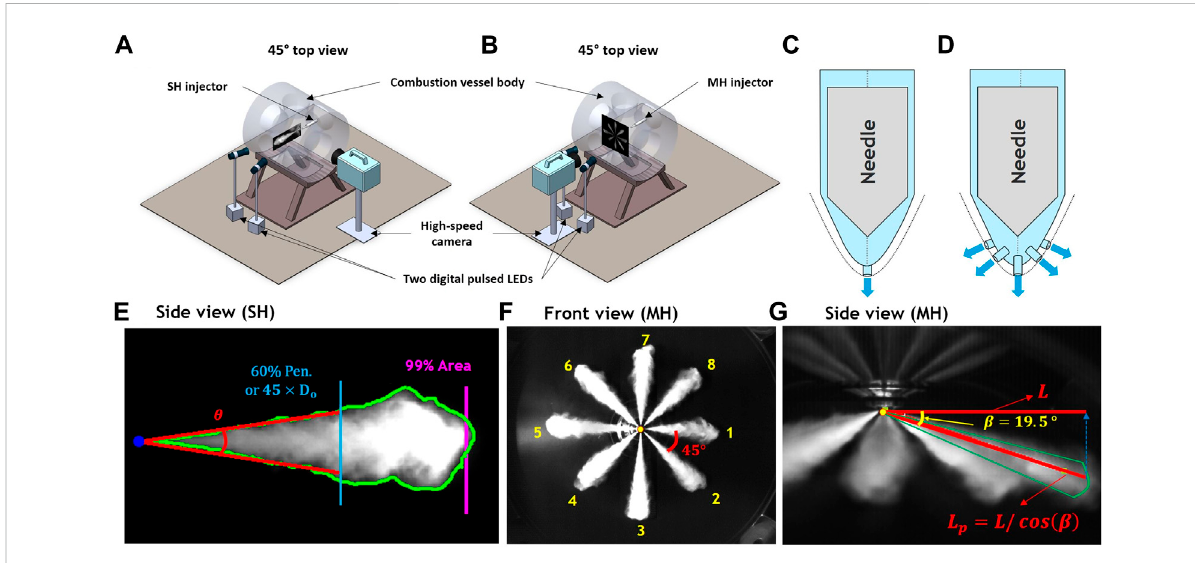
FIGURE 1 Optical setup of the Mie-scattering imaging system of (A) single-hole and (B) multi-hole injectors for the non-reacting, non-vaporizing tests. Schematic of (C) single- and (D) multi-hole injectors. (E) The side view of a single-hole (SH) injector with different de fi nitions of spray penetration lengths(99%area) anddispersionangles(60%penor45×D o ).The (F) frontand (G) sideviewsofthemulti-hole(MH)injectorwithplumeindexbythe determination of the actual penetration length ( L p ) from the visualized penetration length ( L ).